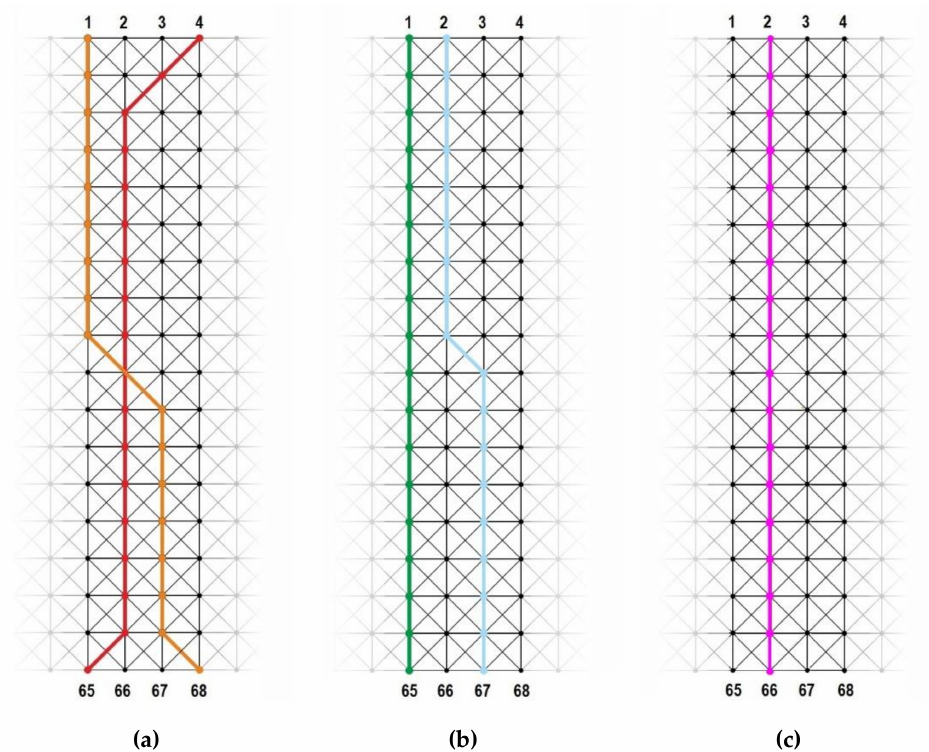
Figure 6. Trajectories with: ( a ) the highest values of E N (No. 1—red, No. 2—orange); ( b ) the lowest values of E N (No. 3—blue, No. 4—green); ( c ) the reference value of E N (No. 5—purple).